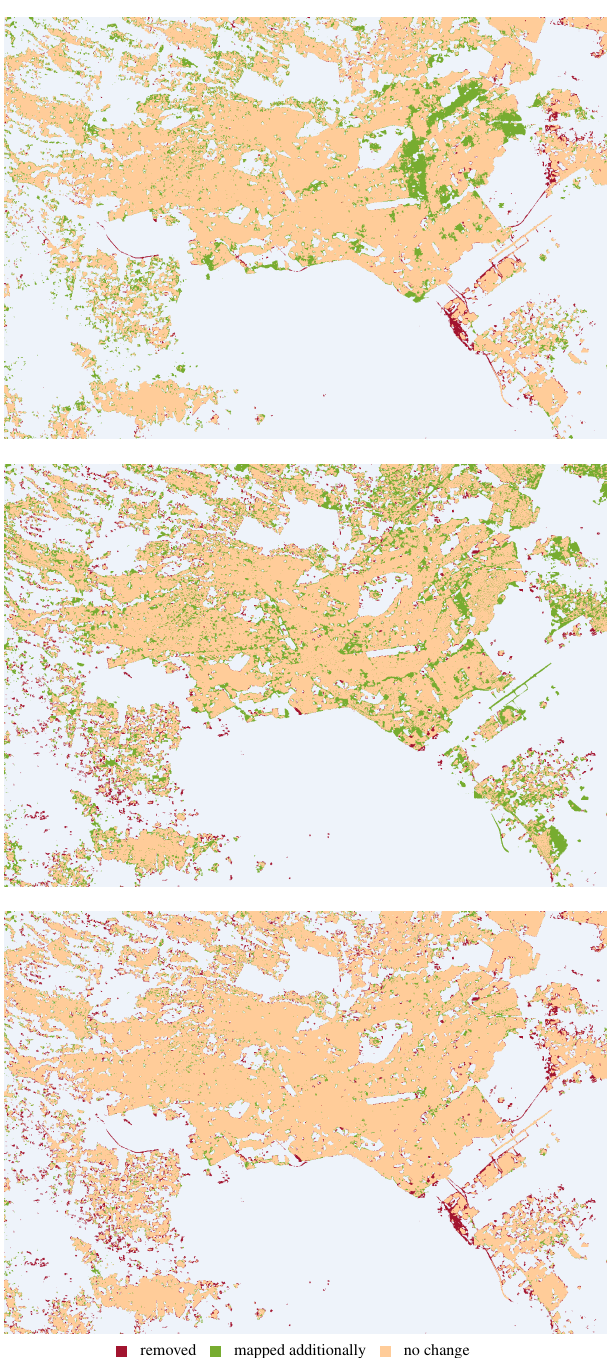
Figure 5. Comparison of the produced results in Nairobi to three kinds of baseline maps: Pre (top), GUF (middle), and Ref (bottom),